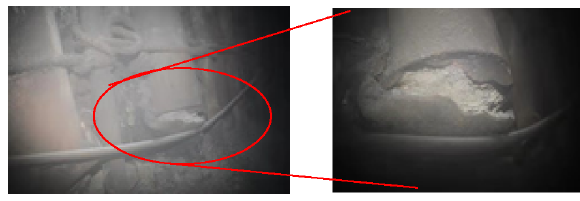
Fig. 1 Characteristics of pier column failure on site